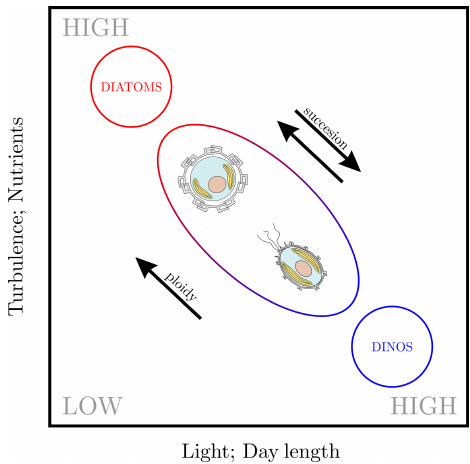
Figure 9. A modified version of Margalef’s niche model (Margalef, 1978), as proposed by Houdan et al. (2006) and Frada et al. (2018). Note that we have added day length, which was proposed by Balch (2004) as a third axis for the Margalef niche